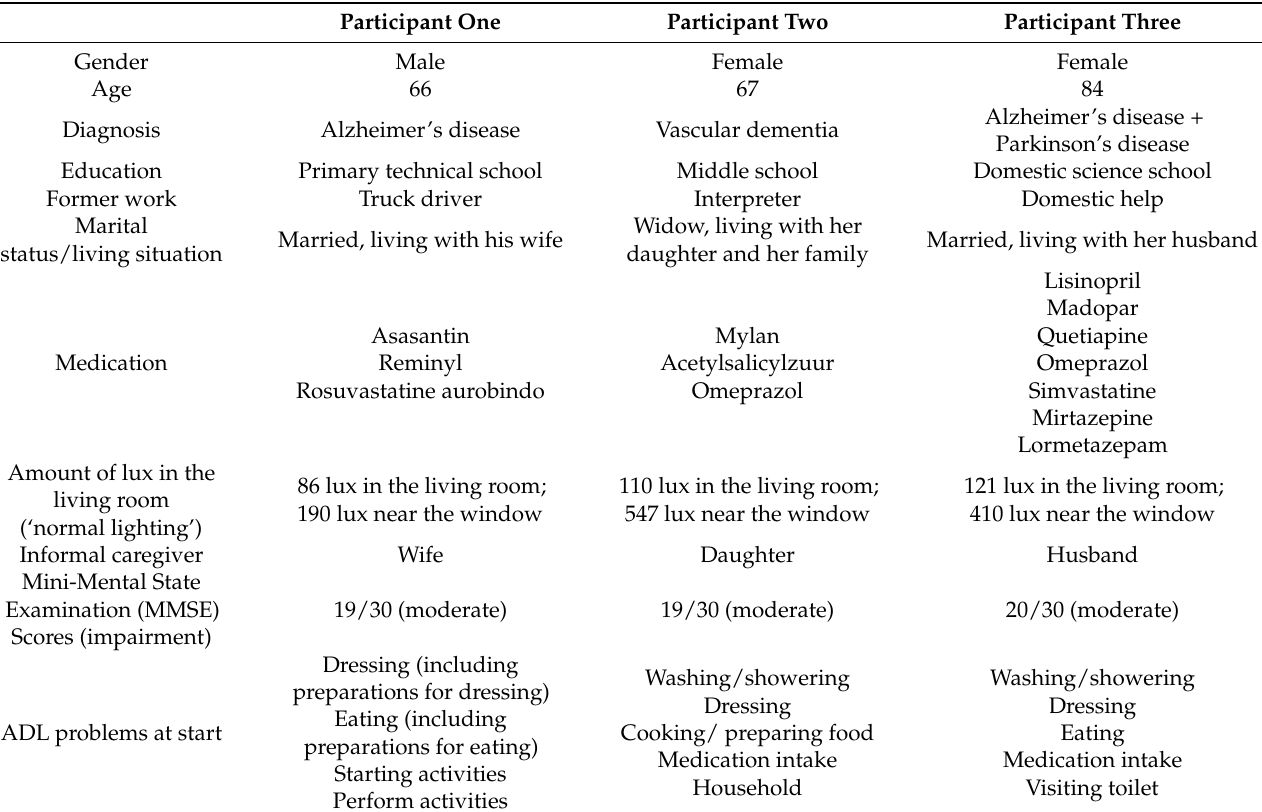
Table 1. Participant characters at